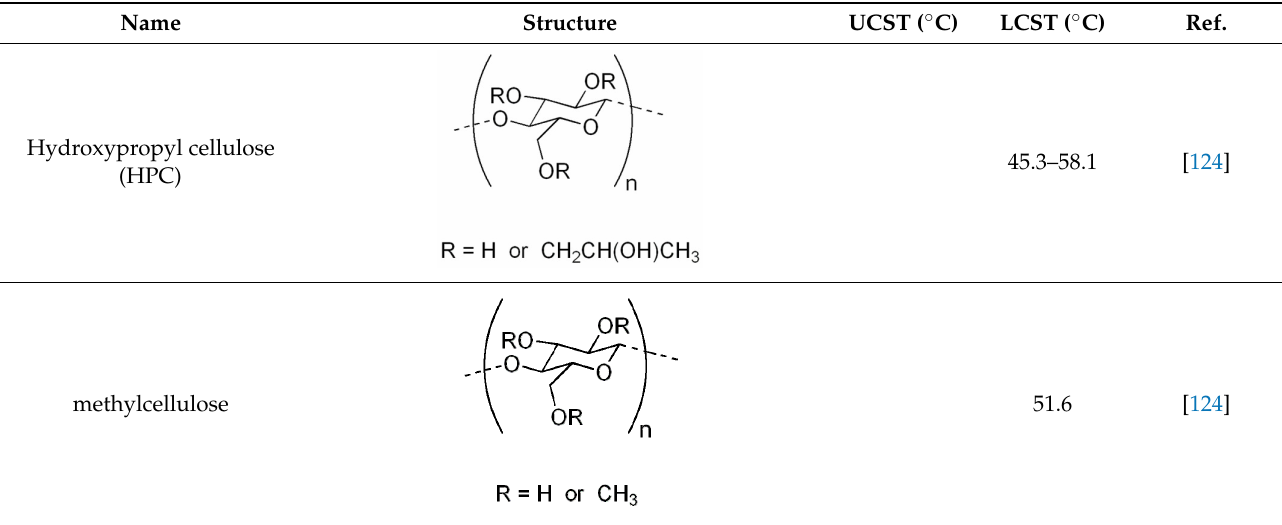
Table 3. List of polymers with thermoresponsive properties.